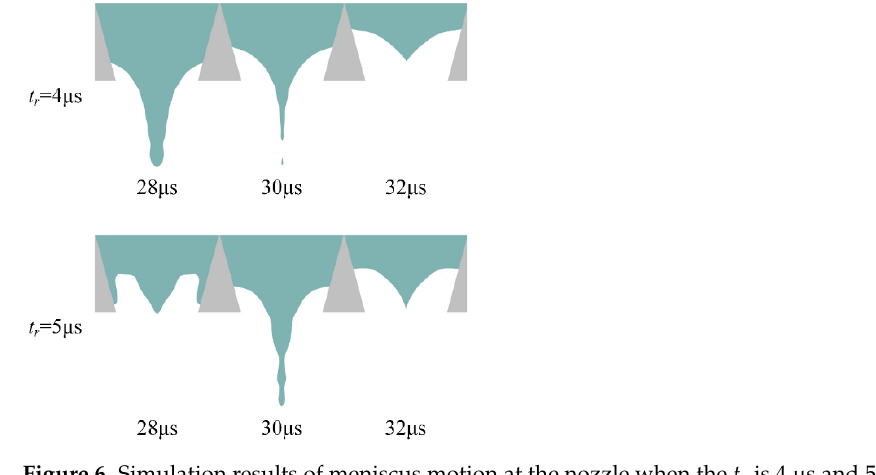
Figure 9. The shape of the pressure curve at the nozzle is similar at different t f . As the t